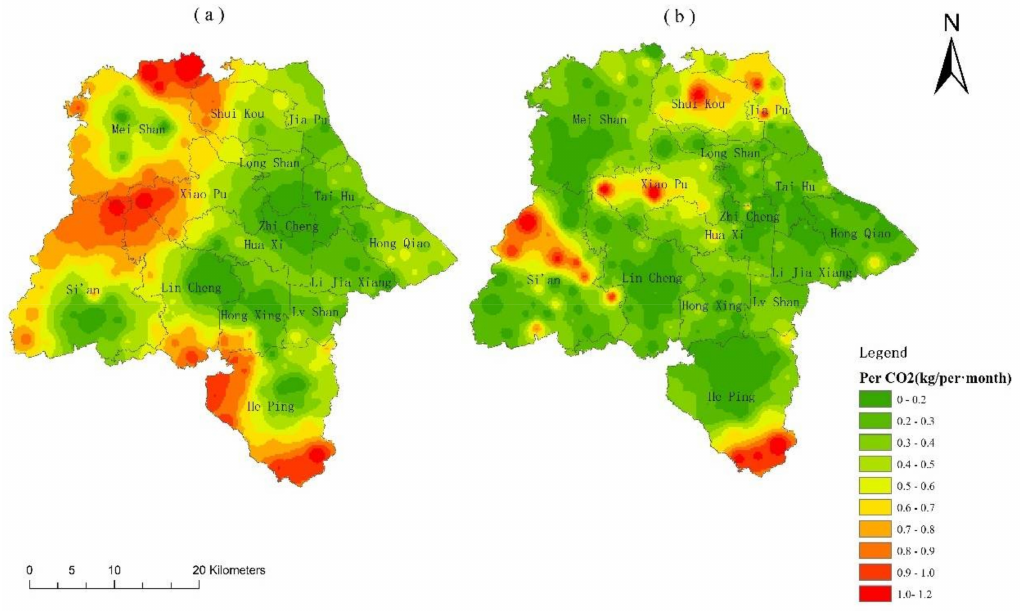
Figure 7. Changes in the spatial distribution of per capita carbon emissions ( a ) current situation ( b ) optimized